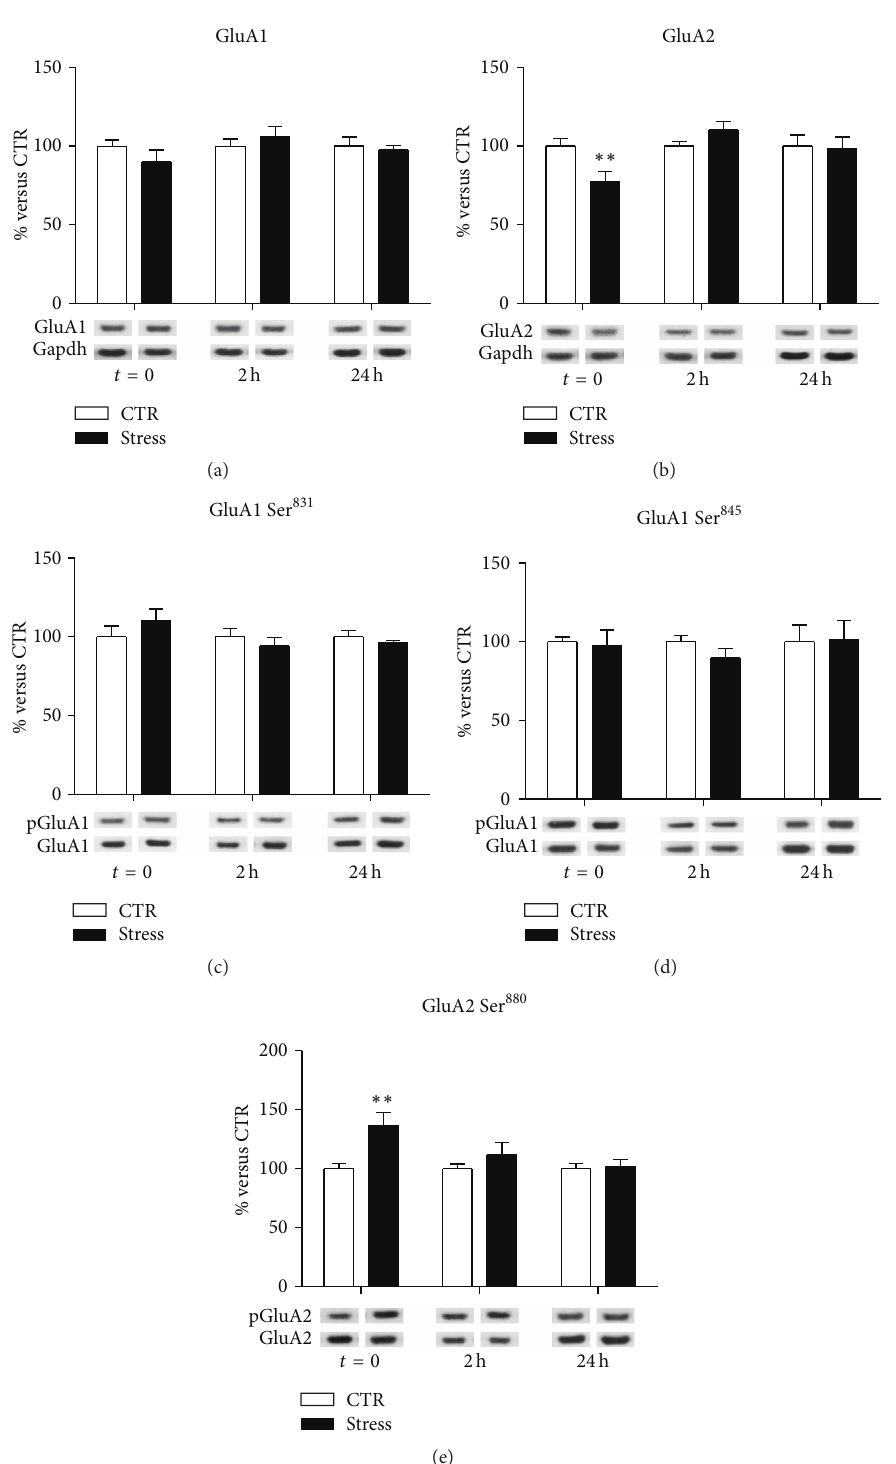
Figure 2: Time-dependent changes of protein expression levels of GluA1 (a), GluA2 (b), GluA1 phospho-Ser 831 (c), GluA1 phospho-Ser 845